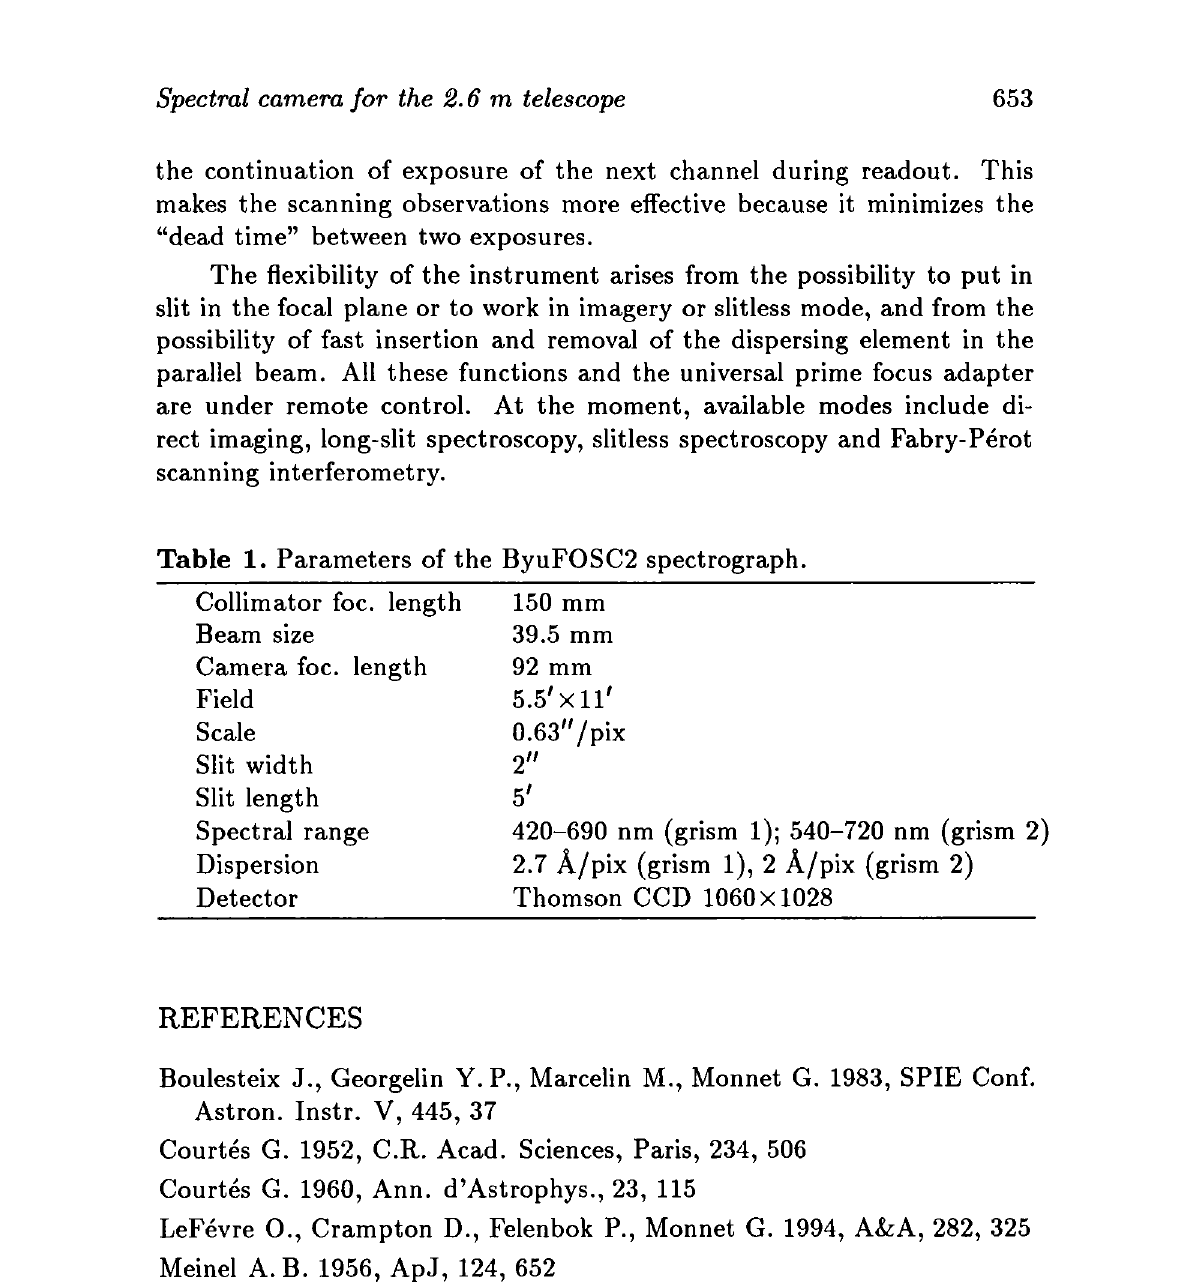
Table 1. Parameters of the ByuF0SC2 spectrograph. Collimator foe.